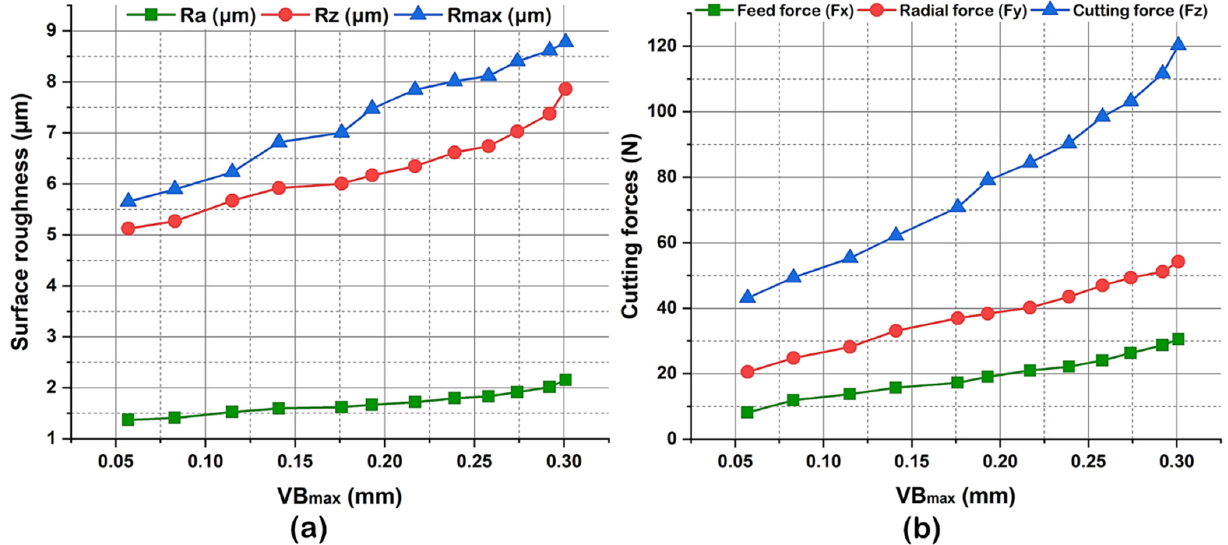
Figure 12. Influence of tool flank wear on ( a ) surface roughness, and ( b ) Cutting forces at V = 247 m/min, f = 0.28 mm/rev, d = 0.4 mm.